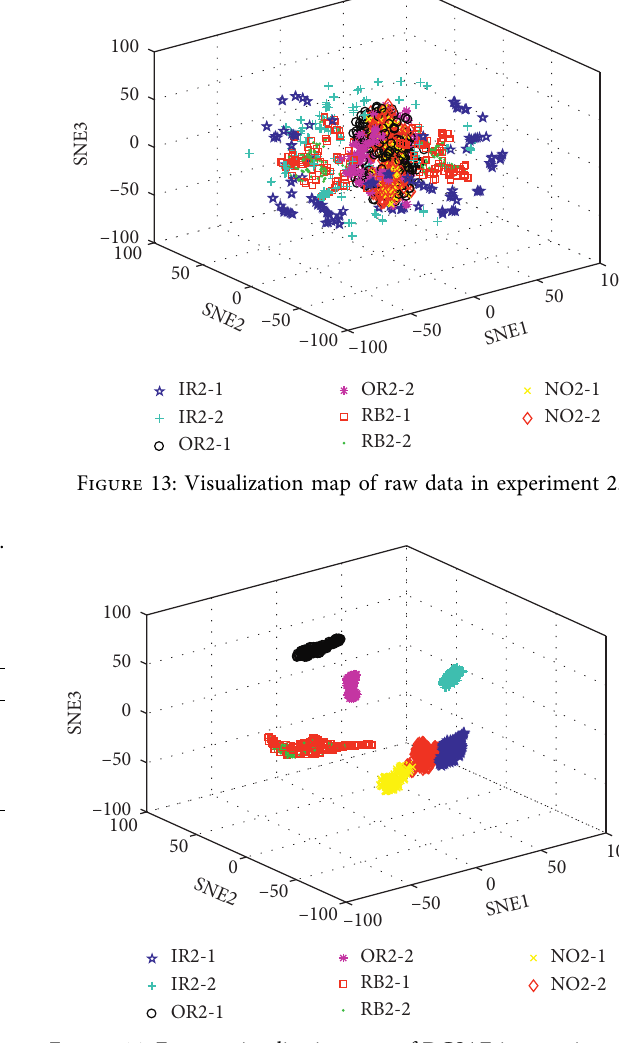
Figure 14: Feature visualization map of DCSAE in experiment 2.